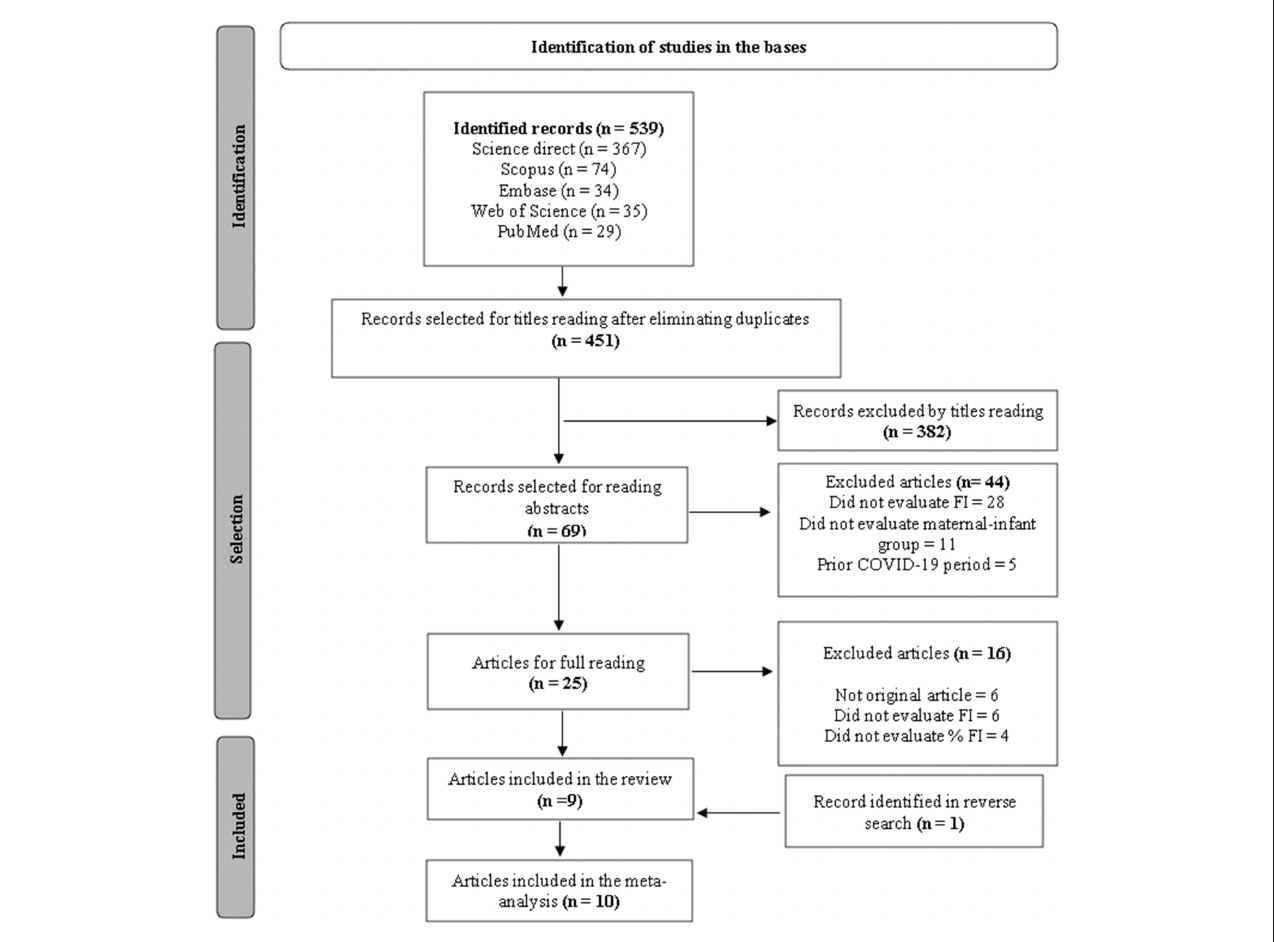
FIGURE1 Flowchart for selecting articles according to the PRISMA methodology. FI, Food